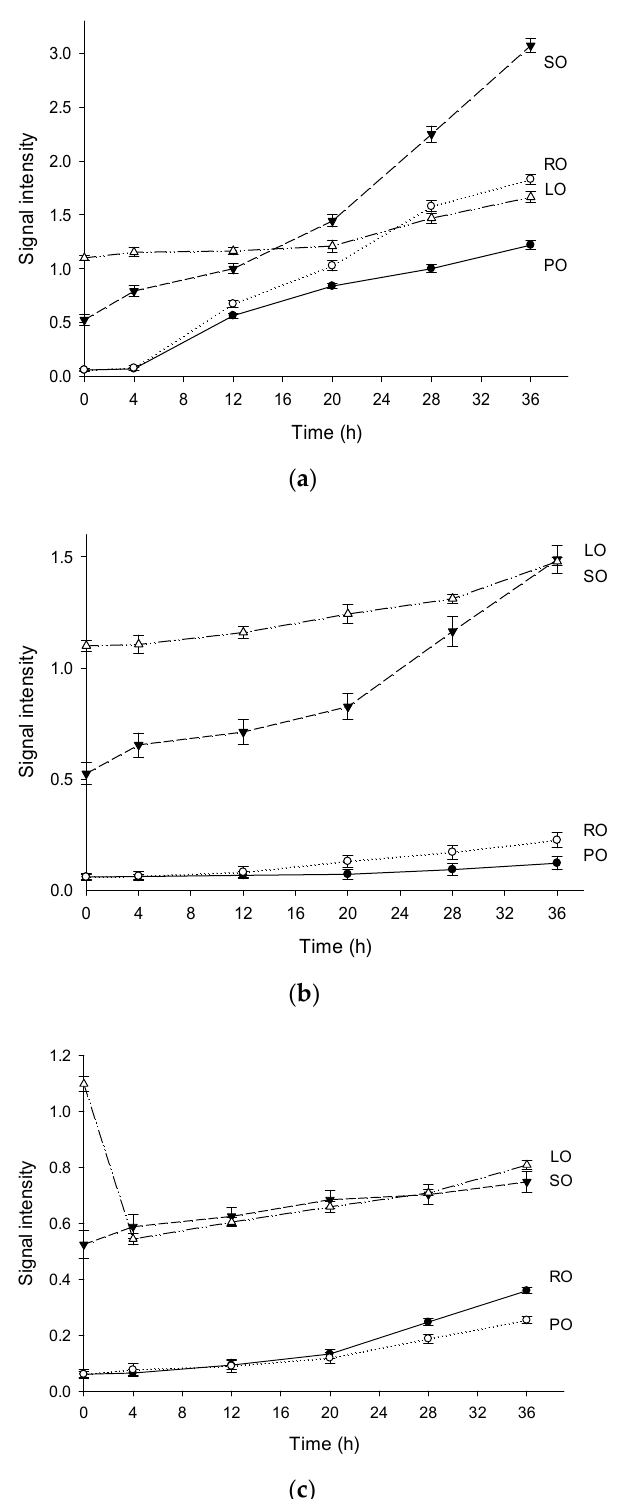
Figure 2. The variation tendencies of signal intensities in four vegetable oils heated at 120 °C ( a ), 150 °C ( b ), 180 °C ( c ). (Note: Exp, experimental spectrum. Sim, simulation of the EPR spectrum. •OOR, simulation of the DMPO/•OOR spectrum. •OR, simulation of the DMPO/•OR spectrum. •R, sim- ulation of the DMPO/•R spectrum. •Mix, simulation of the DMPO likely adducts. PO, palm oil. RO, rapeseed oil. SO, sunflower oil. LO, linseed oil).